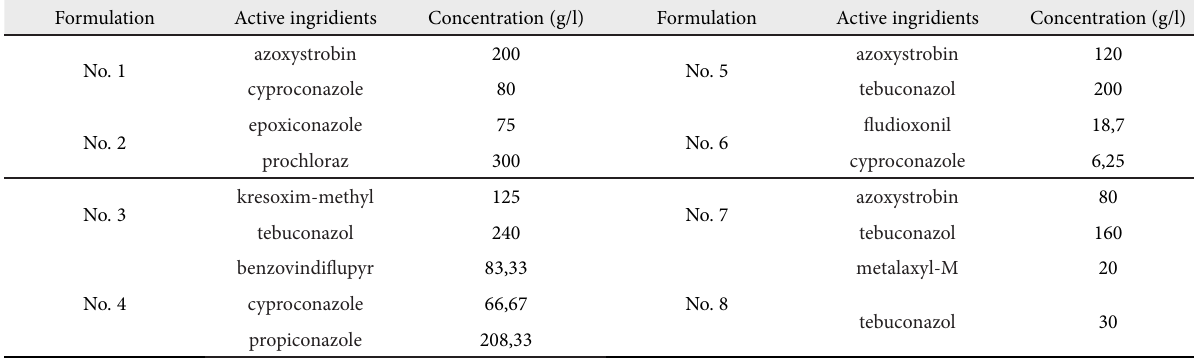
The composition of the studied combined fungicides (Formulations No. 1–8)